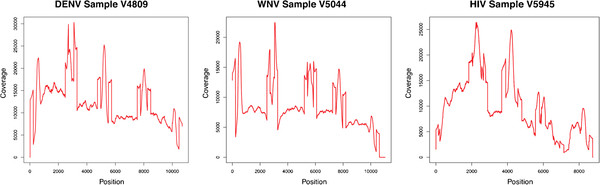
Coverage plot. Fold sequence coverage across the target regions of one representative sample for DENV, WNV, and HIV full-length genomes. Coverage is measured as the total number of reads uniquely aligning over a given residue; alignments are to standard references (see Methods).